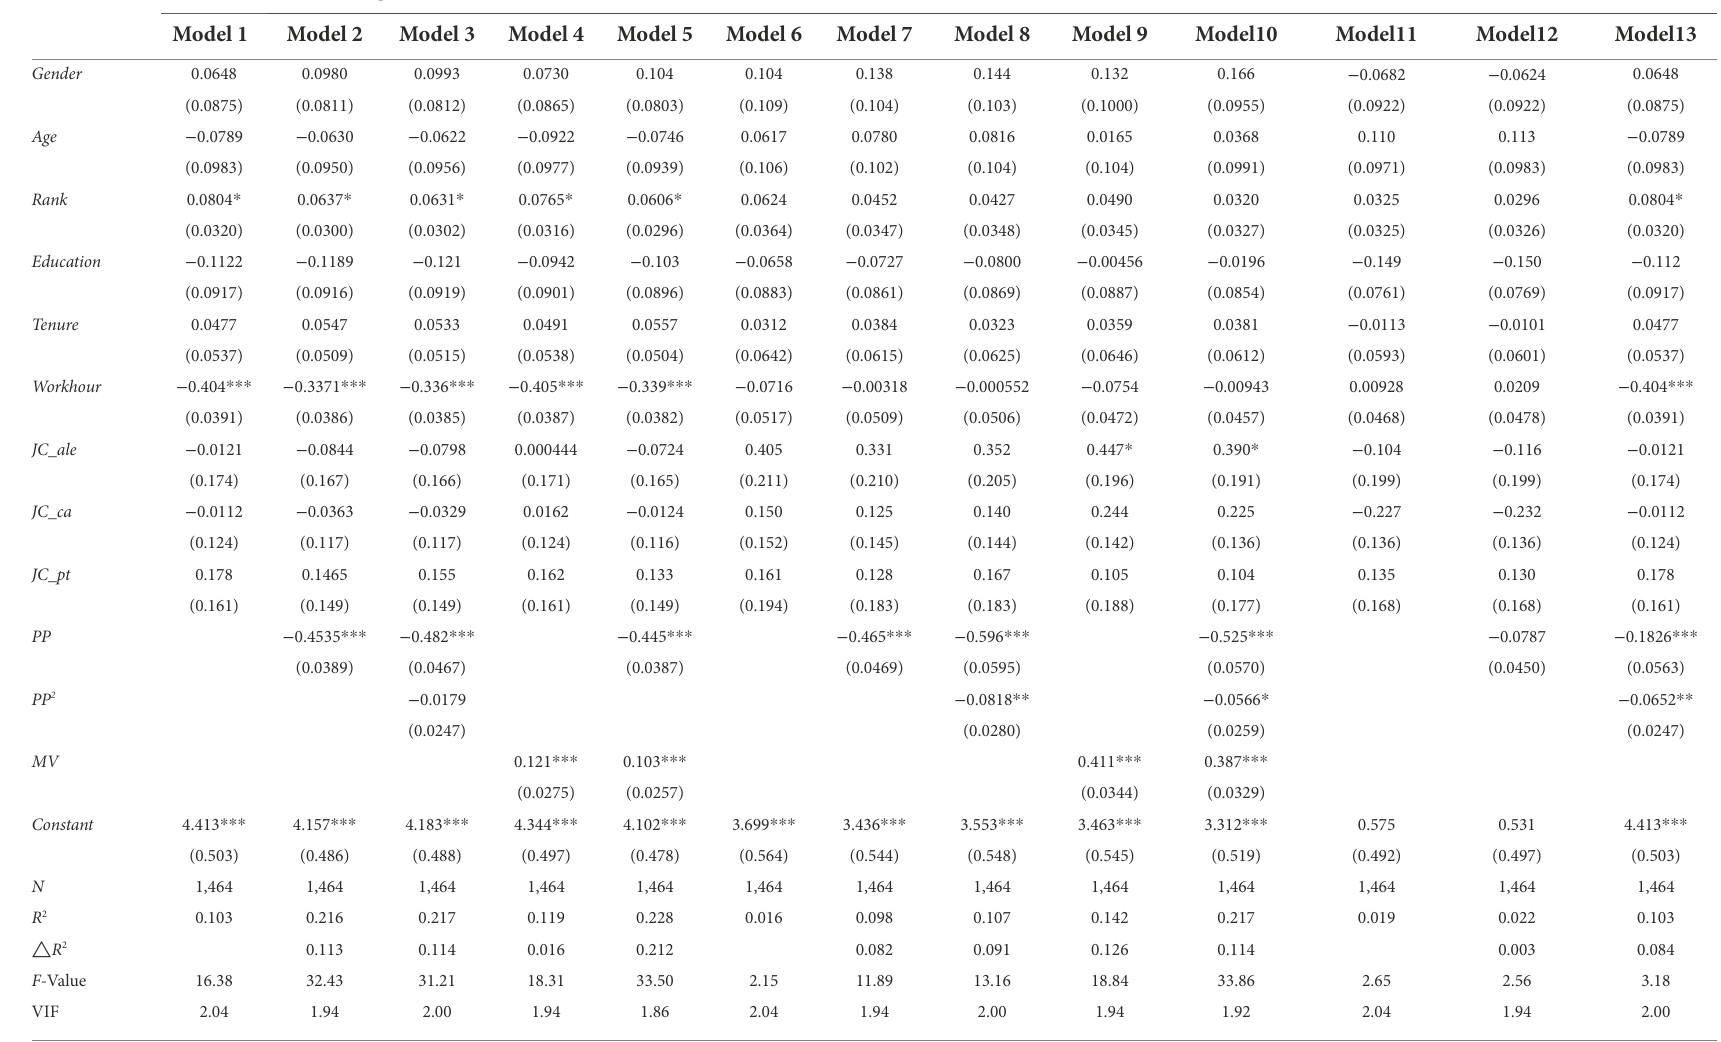
TABLE 6 Regression results for the main effect and mediating effect